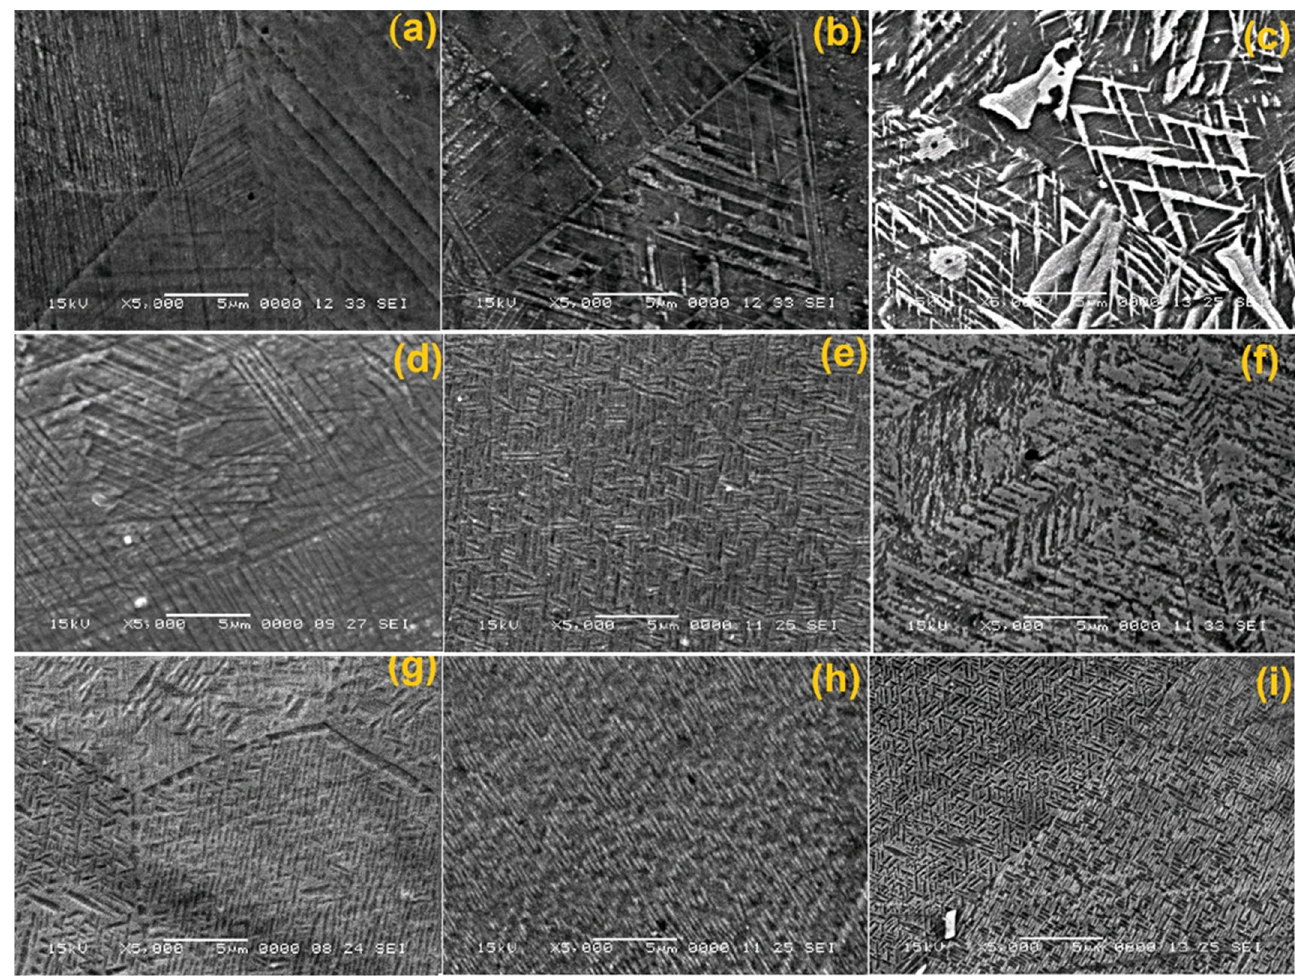
Figure 5. Typical SEM micrographs of solution-treated specimens after the application of DMA-SS- 3PB: ( a ) 2 h–1 Hz; ( b ) 6 h–1 Hz; ( c ) 10 h–1 Hz; ( d ) 2 h–5 Hz; ( e ) 6 h–5 Hz; ( f ) 10 h–5 Hz; ( g ) 2